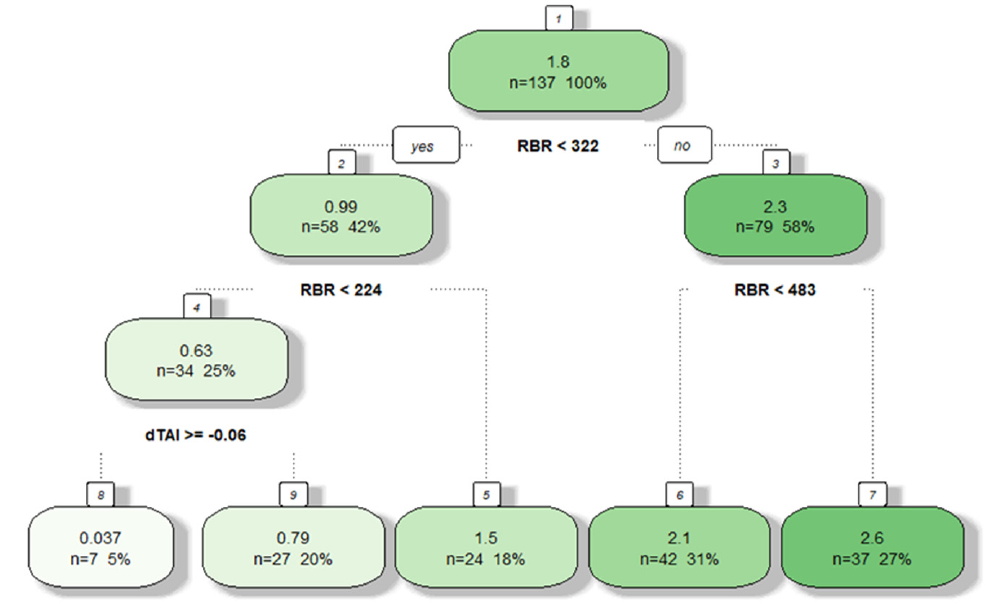
Figure 6. Regression tree (RPART) model for explaining CBI based on spectral severity indices (RBR, dNBR, dTAI, and dBAIS2) used as explanatory variables.